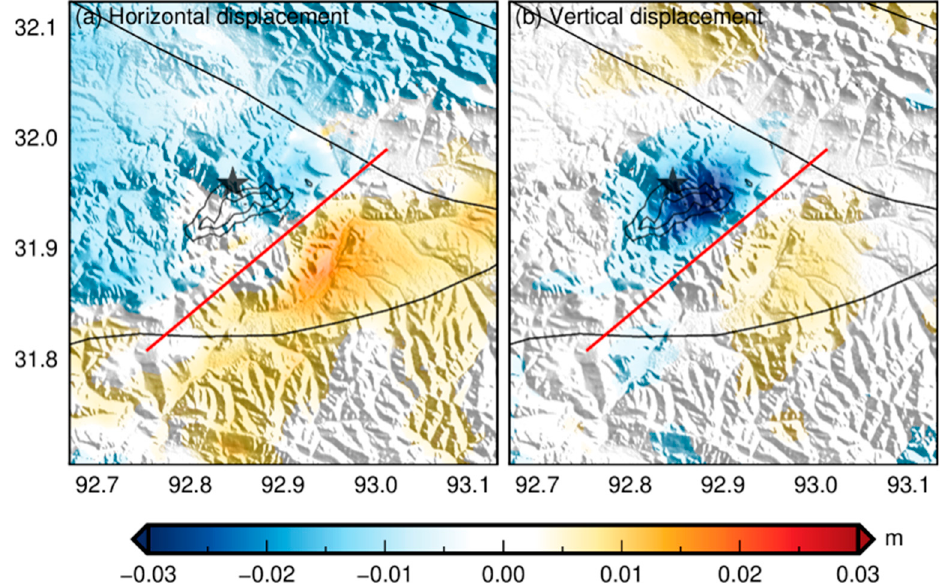
Figure 3. Two-dimensional coseismic surface displacement maps. ( a ) Horizontal displacement in the strike direction (red line). Positive values represent the motion toward to northeast along the strike direction. ( b ) Vertical displacement. Negative values represent subsidence. Black contour with a 0.1 m interval is the coseismic slip model.